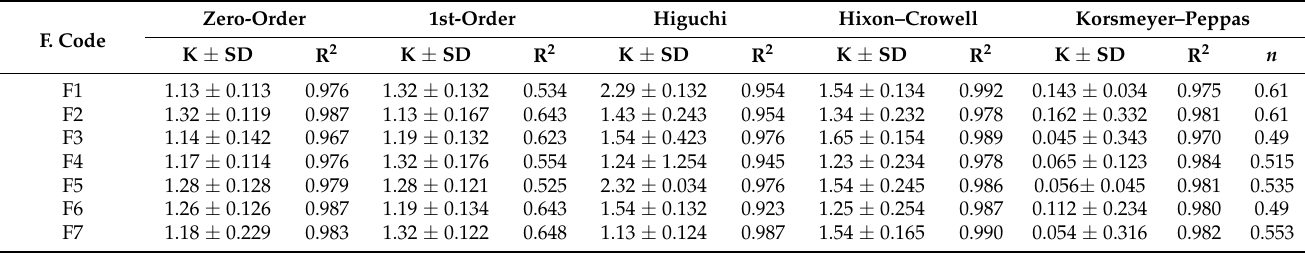
Table 4. Values for the release exponent and linearity in kinetic models (Korsmeyer–Peppas kinetics).